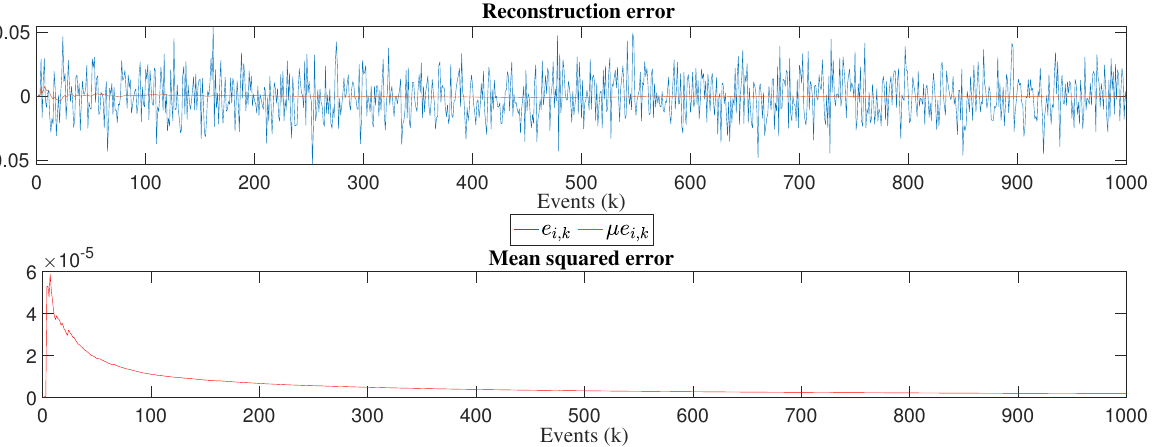
Figure 15. Graph of the reconstruction error and mean squared error for the 64 × 64 matrix inversion